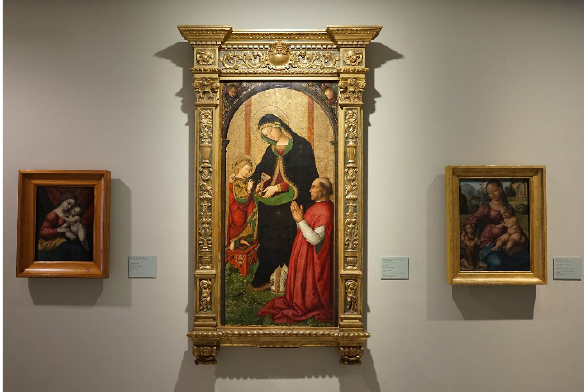
Figure 1 . Virgen de las Fiebres by ‘Il pinturichio’ (ca.1500). Museo de Bellas Artes de Valencia (Spain).